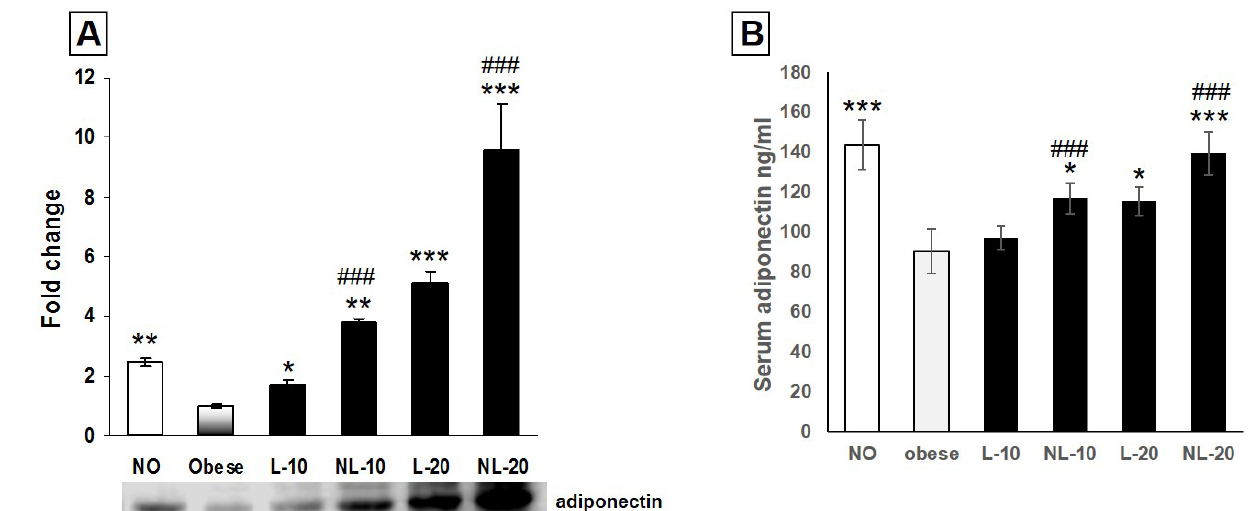
FIGURE 3- Effect of lupine oil on adiponectin expression: (a) adiponectin expression determined by Western blot analysis in the epididymal fat. (b) Serum level of adiponectin determined by ELISA. NO : non-obese group, Obese : obese untreated group, L-10 and L-20 : crude lupine oil treated groups after 10 and 20 days, NL-10 and NL-20 : Lupine oil nanoemulsion treated groups after 10 and 20 days. Data are represented as means ± SD, ( n = 5). * P < 0.05, ** P < 0.01 and *** P < 0.001 when compared with obese untreated values. # P < 0.05, ## P < 0.01 and ### P < 0.001 when crude oil preparation group is compared to its corresponding nanoemulsion formulation group (L-10 versus NL-10 and L-20 versus